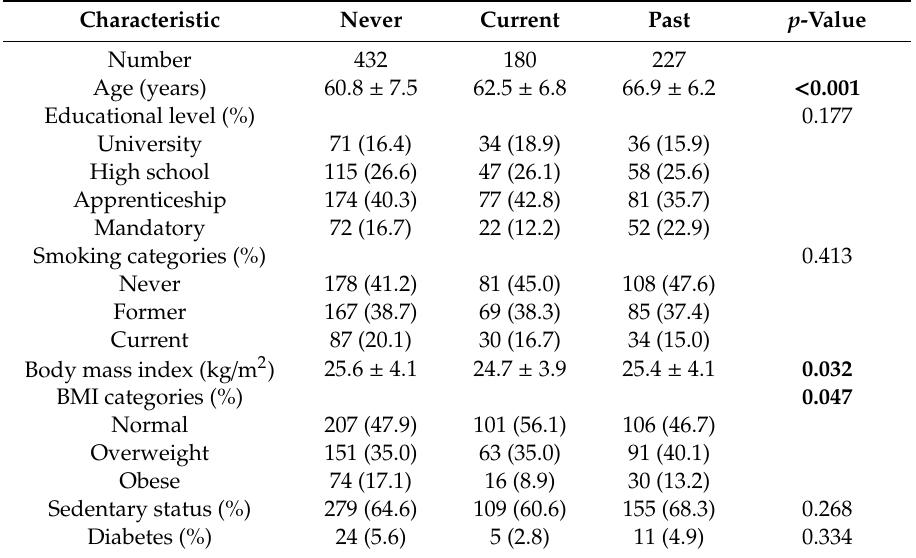
Table 1. Characteristics of the participants according to menopausal hormone